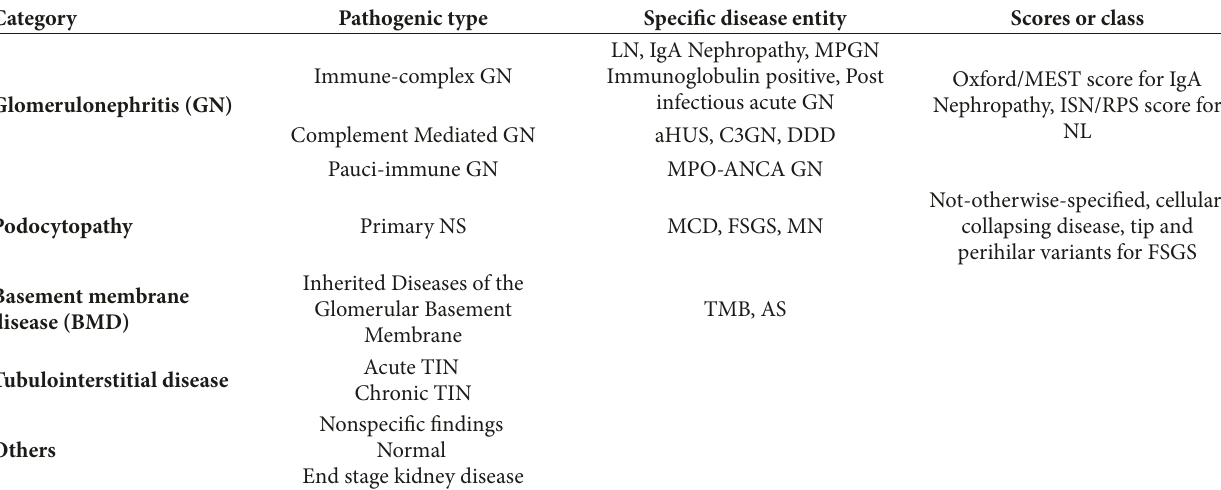
Table 1: Histopathological findings